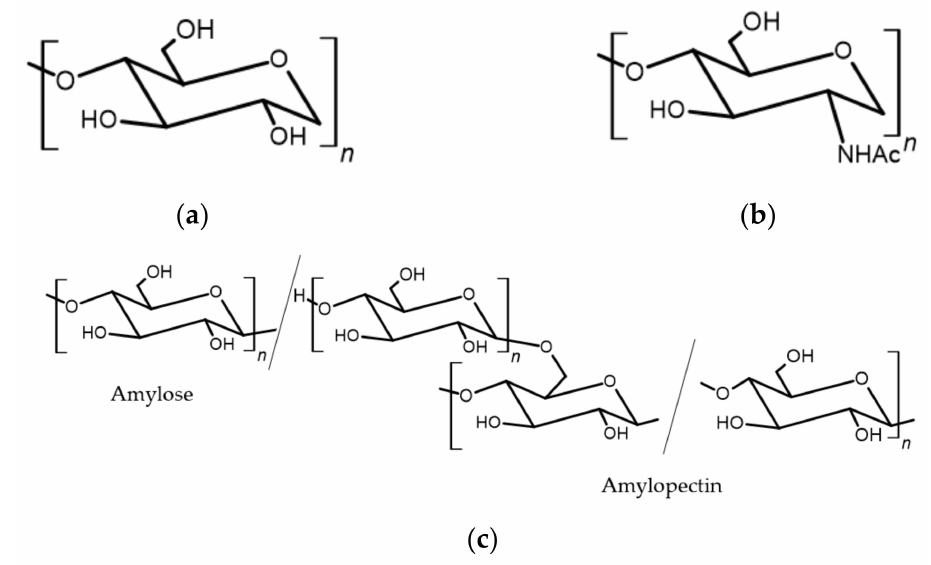
Figure 4. Structures of different polysaccharides [16]: ( a ) cellulose; ( b ) chitosan; ( c )